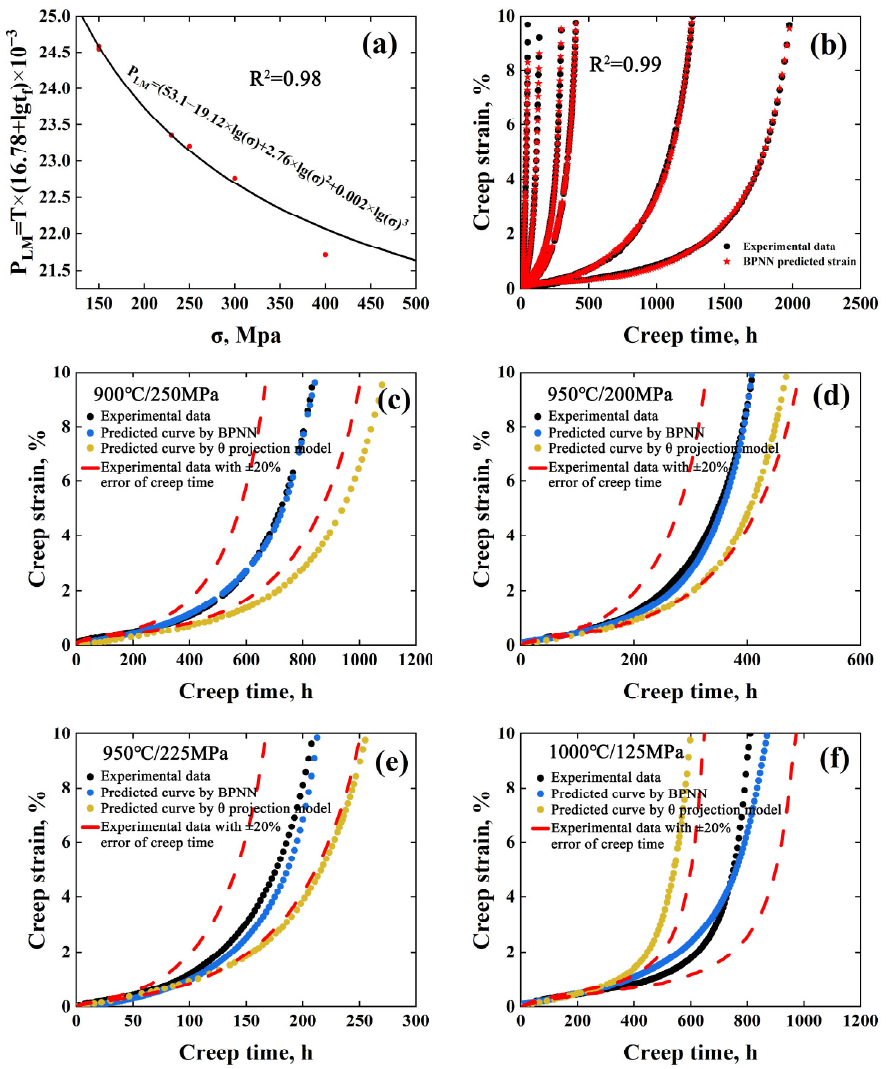
Figure 2. ( a ) The fitted result by Larson–Miller equation, ( b ) comparison of predicted and experimental values of the training datasets and ( c – f ) comparison of experimental data, the prediction of the BPNN model and the θ projection model of the test datasets.